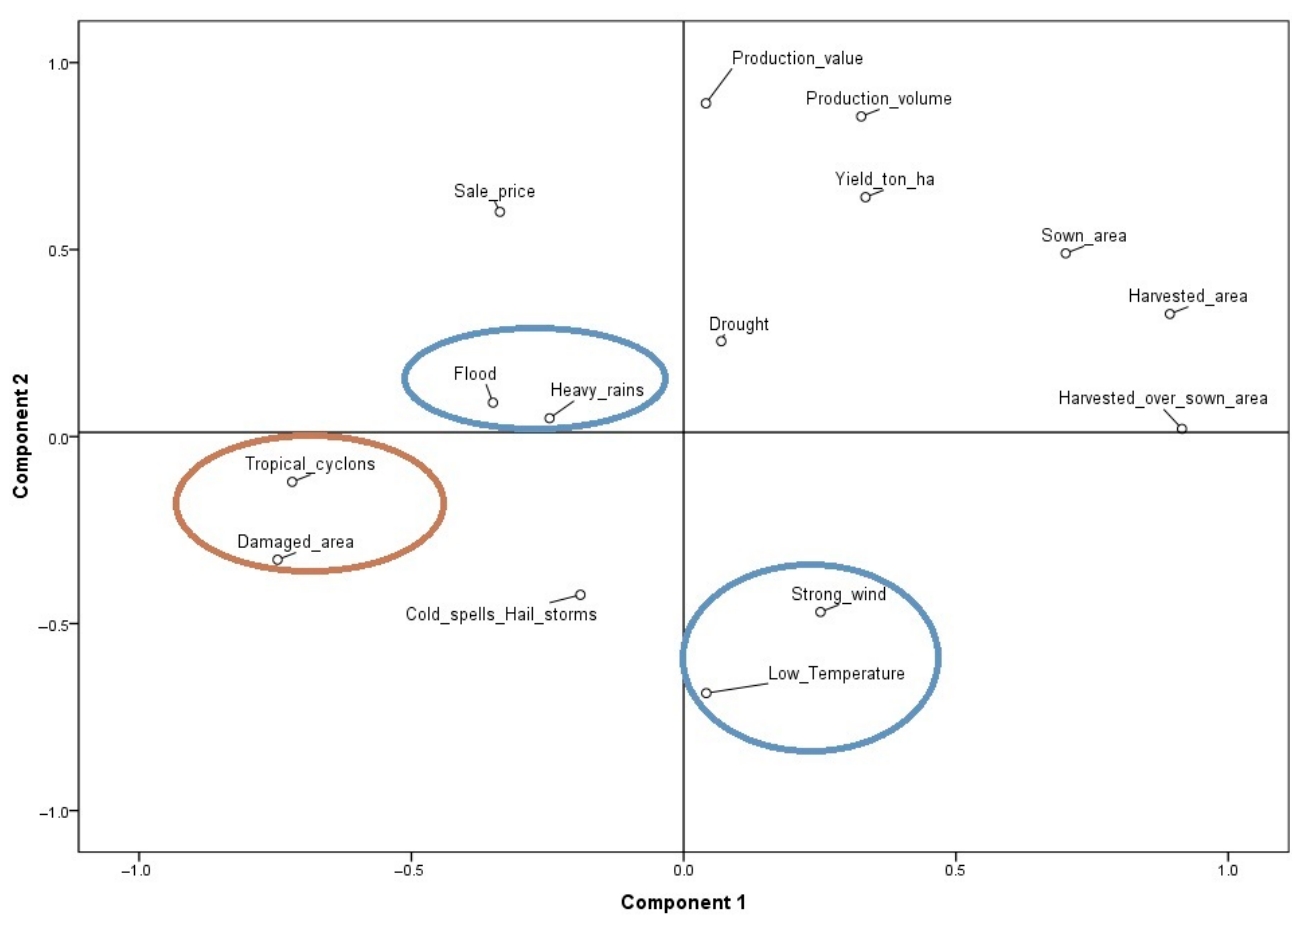
Figure 4. Principal component analysis of hydrometeorological phenomena causing disaster declarations and agricultural production data in the State of Veracruz from 2001 to 2020. The circles indicate the most related phenomena.